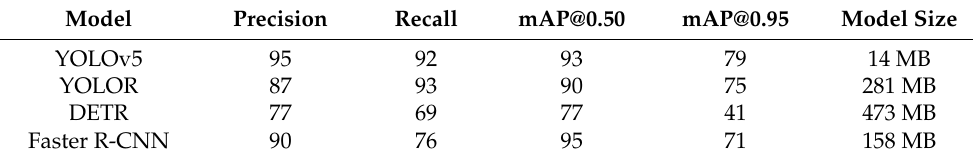
Table 2. Comparison of model performances for different DL